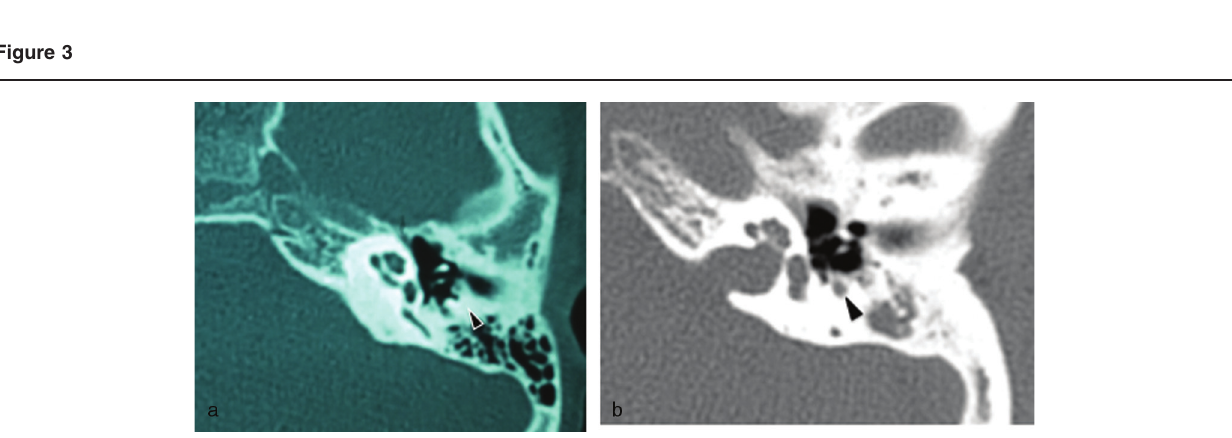
A: Indicate type 3 (absent of sentinel cell, black arrow). B: Indicate type 3 (sclerotic mastoid in OME with protrusion of facial nerve, black arrow)